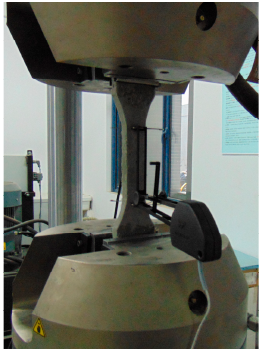
Figure 4. Test device for tension.